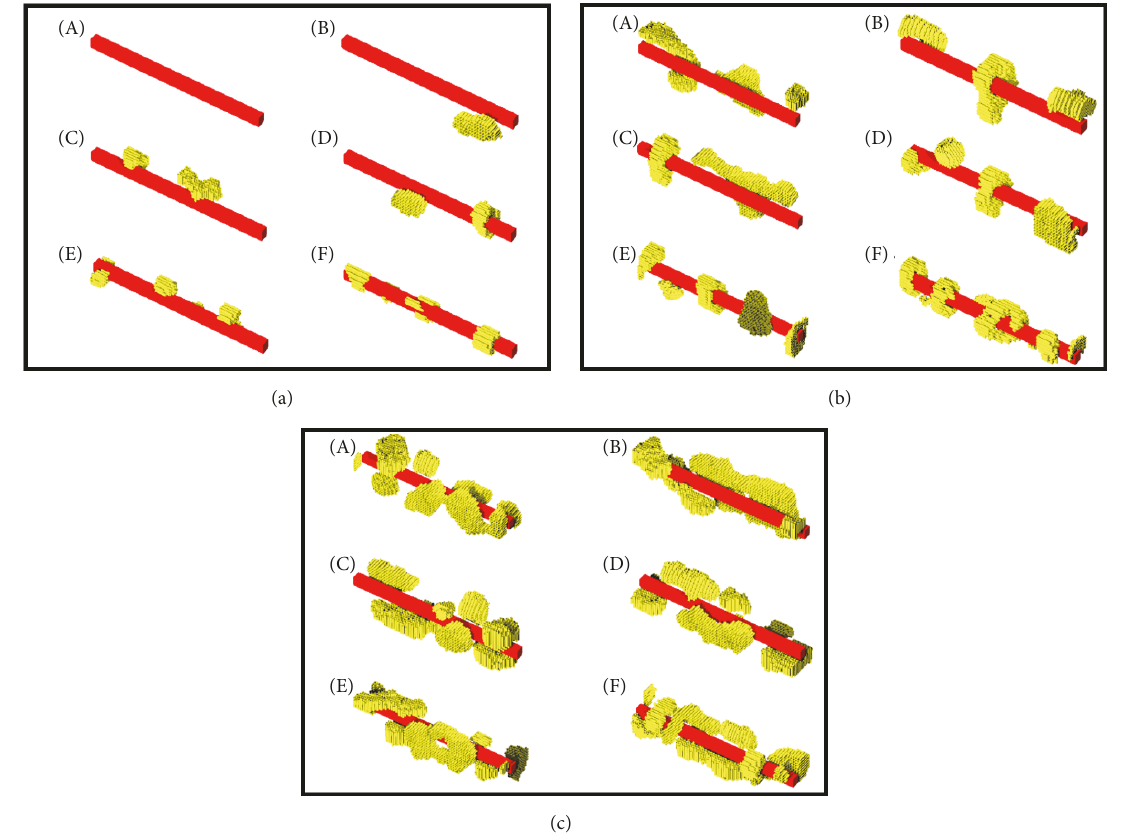
Figure 9: The crystalline morphologies on 300000 Monte Carlo cycles of three systems for 52(a), 128(b) and 252(c) polymer chains with the polymer-nanorod interactions of 0 (a)–(c)(A), -0.1 (a)–(c)(B), -0.2 (a)–(c)(C), -0.3 (a)–(c)(D), -0.4 (a)–(c)(E), and -1.0 (a)–(c)(F). Yellow cylinders represent for the crystalline stems and the red parts denote the